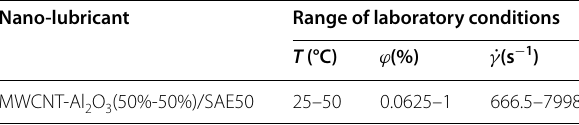
Table 2 Range of conditions for measuring the µ nf Nano-lubricant